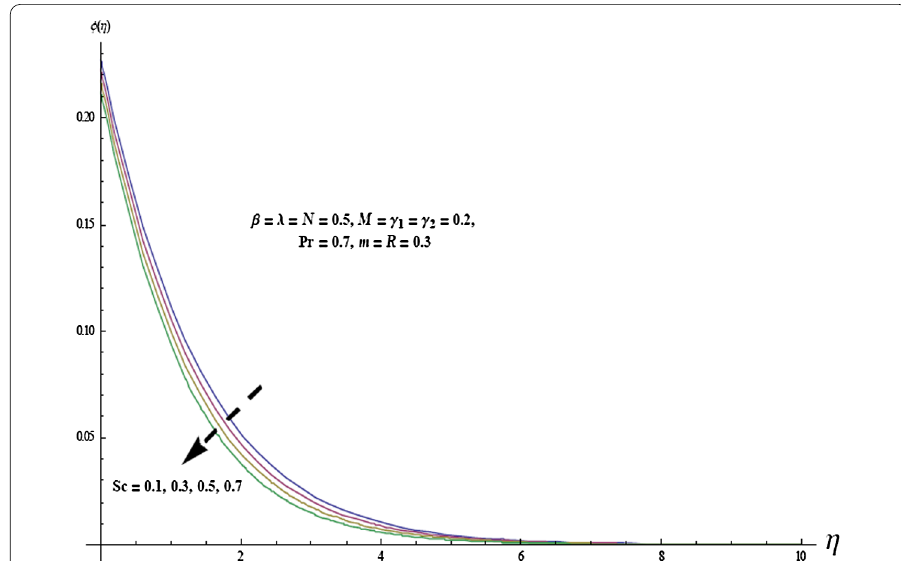
Figure 14 Variation of Sc on ϕ ( η ).